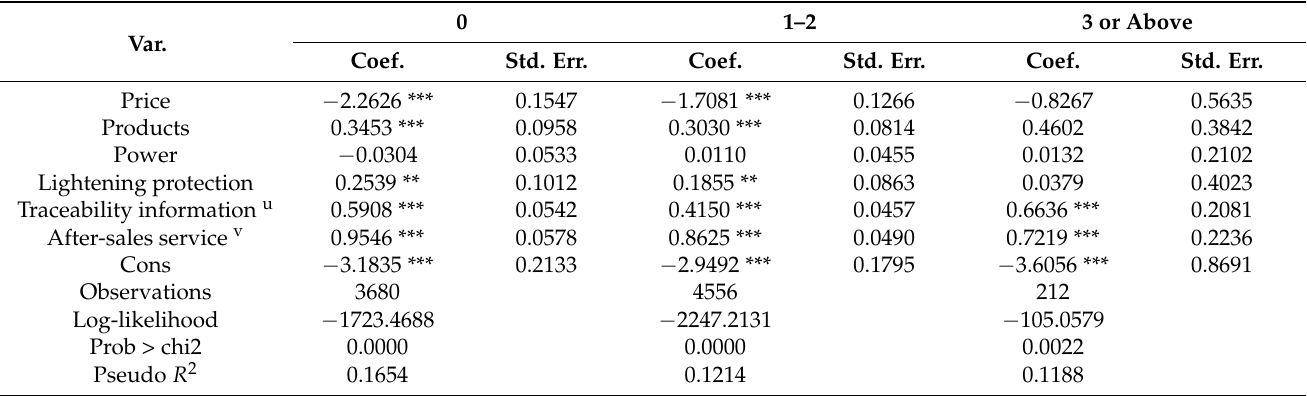
Table 12. Regression results by number of minor children at home grouping.